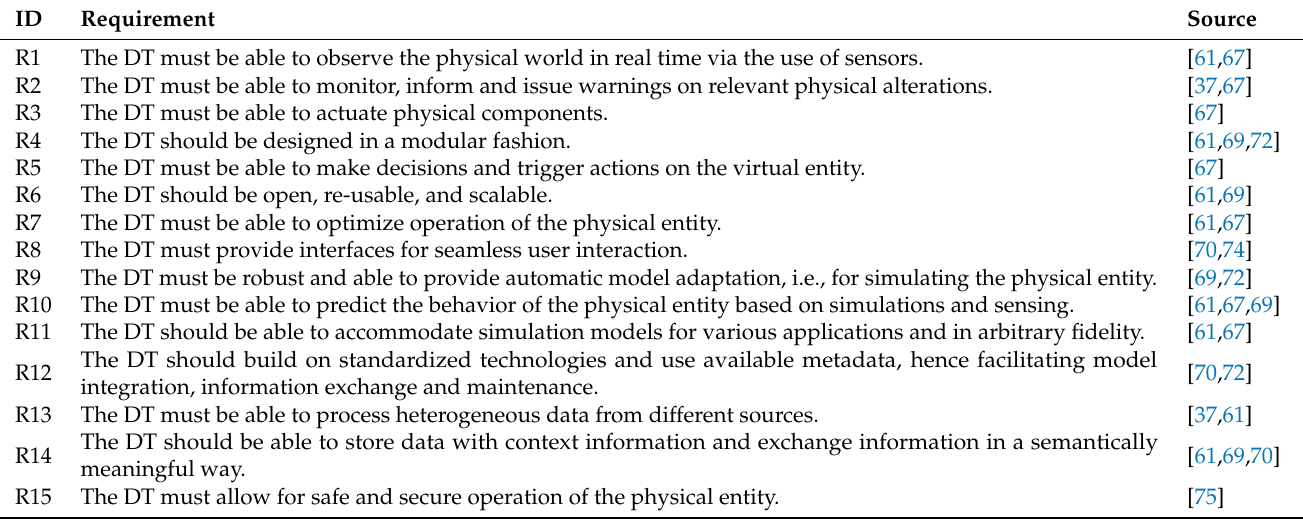
Table 3. Requirements of DT platfoms for application in IES. The requirements are specified together with an identifier for later reference and with literature sources that provided motivation for